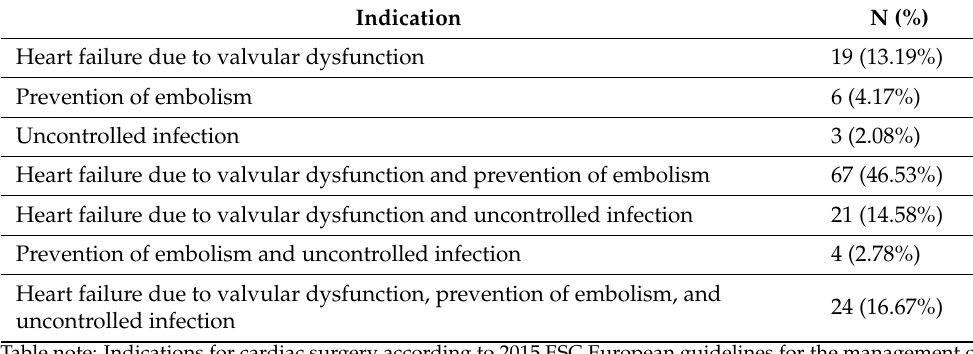
Table note: CoNS—coagulase-negative staphylococci; BMI—body mass index; IE—infective endocarditis. p -Values < 0.05 highlighted in bold. Table 2. Patients’ indications for cardiac surgery due to IE.